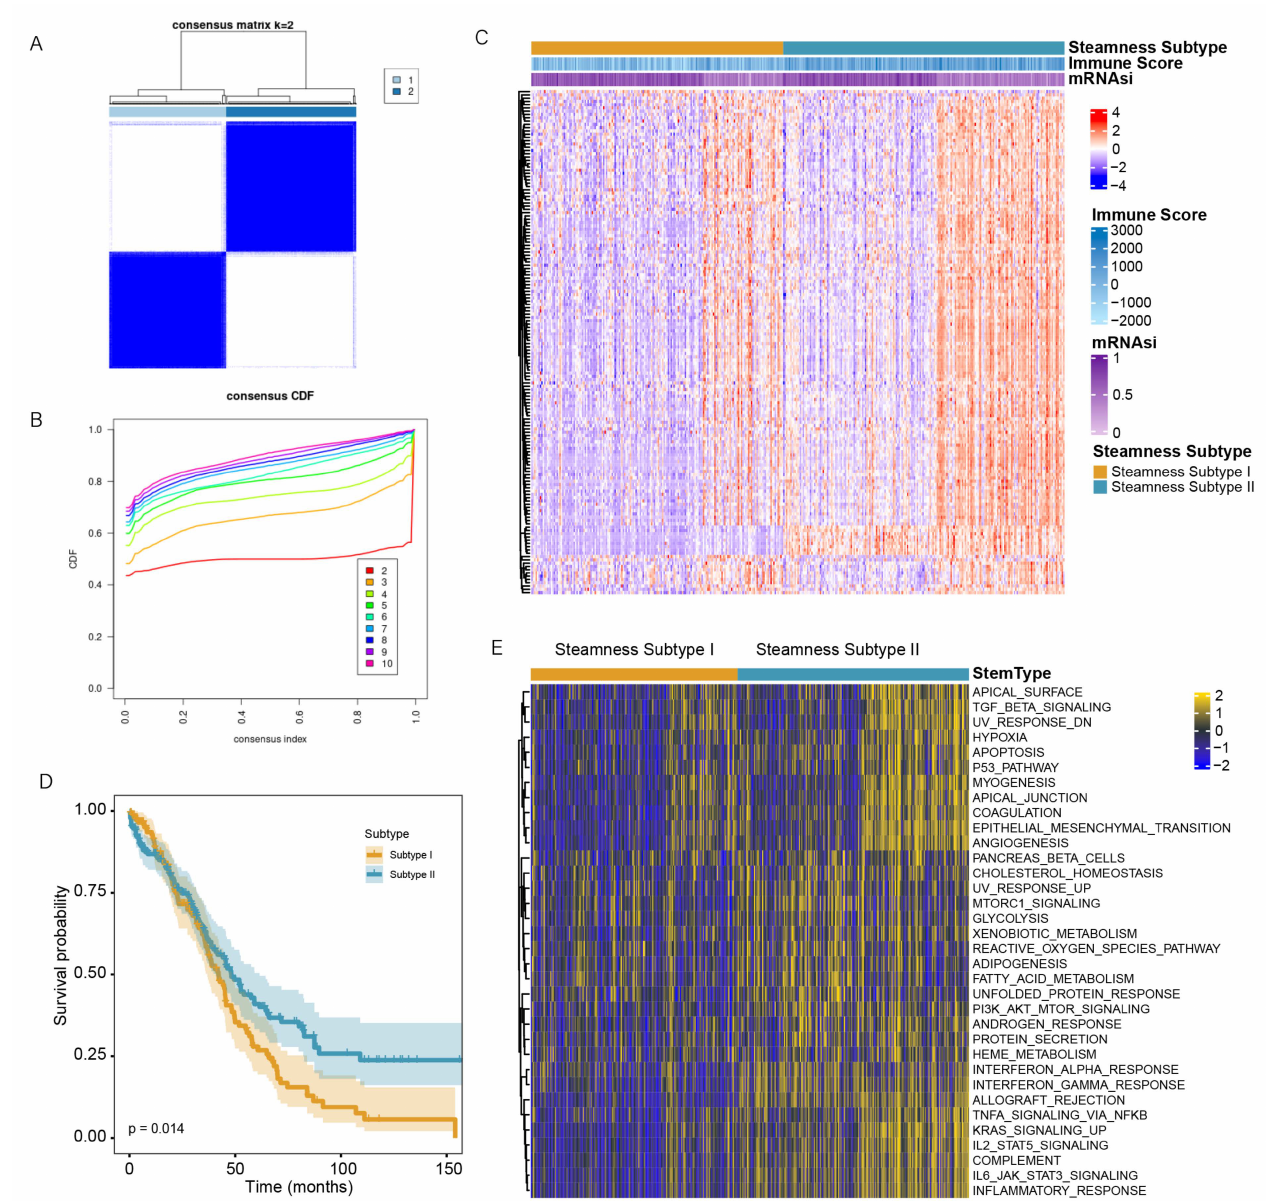
Figure 4. Identification of the two stemness subtypes. ( A ) Consensus clustering heatmap when k = 2. ( B ) CDF curves of the consensus score from k = 2 to 10. ( C ) The heatmap of DEGs between the two subtypes. ( D ) KM curve analysis exhibited that the patients in stemness subtype II have significantly better OS. ( E ) Heatmap showed 33 differentially enriched pathways between the 2